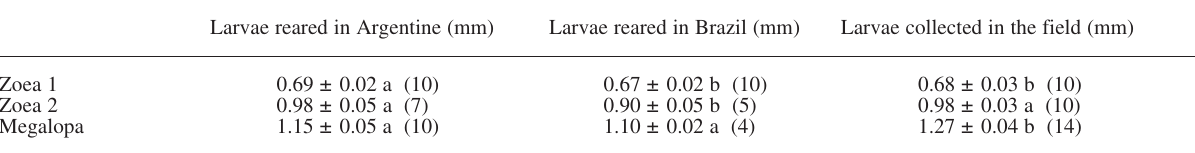
ABLE 1. – Comparison of carapace length (mean ± SD) of Pyromaia tuberculata larvae, between larvae reared in Argentine (this study), Brazil (NEBECCLC 00077 and 00097) and collected in the field. Different letters indicate significant differences detected by All Pairwise Multiple Comparison Procedures (P<0.05): Dunn’s Method after ANOVA on Ranks (zoeae 1 and 2) or Student-Newman-Keuls Method after ANOVA (megalopae). The number of specimens measured was specified between brackets. Larvae reared in Argentine (mm) Larvae reared in Brazil (mm) Larvae collected in the field